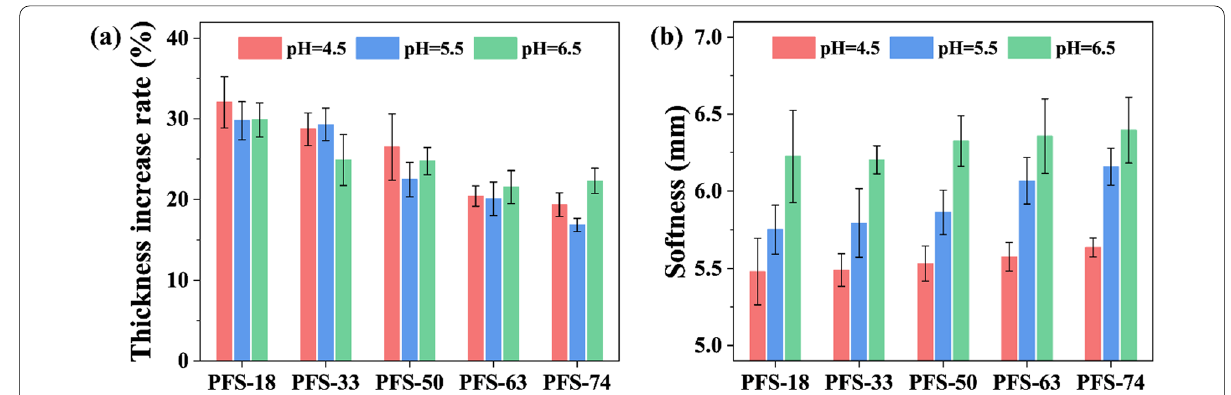
Fig. 8 a Thickness increase rate and b softness of crust leather retanned by PFS with different